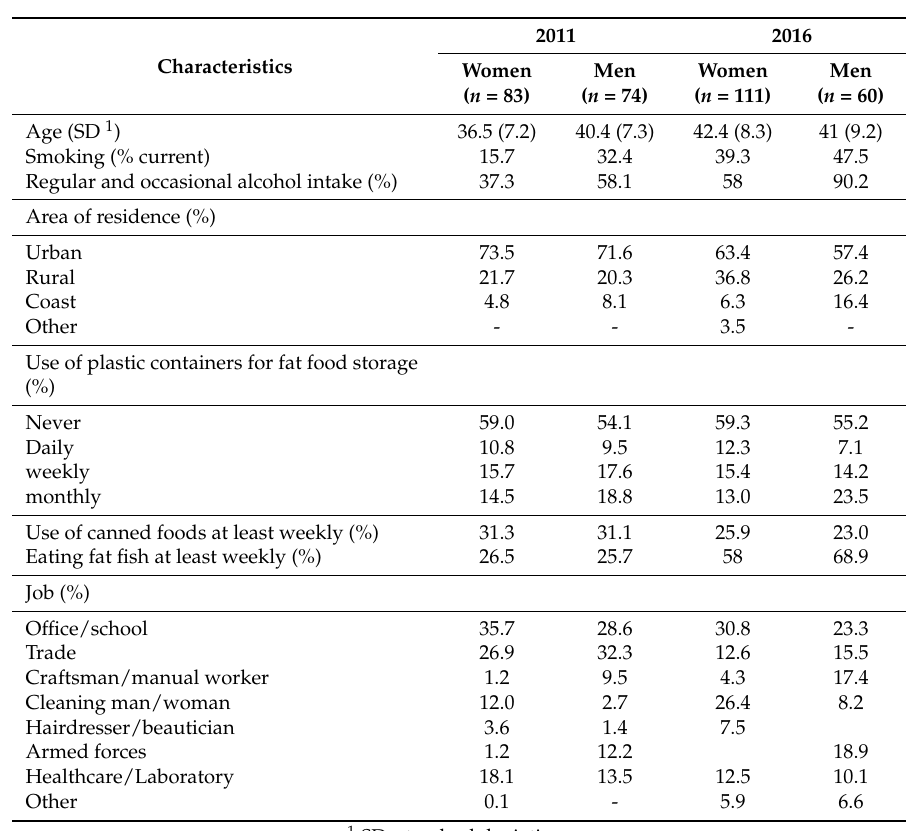
Table 3. Questionnaire results.